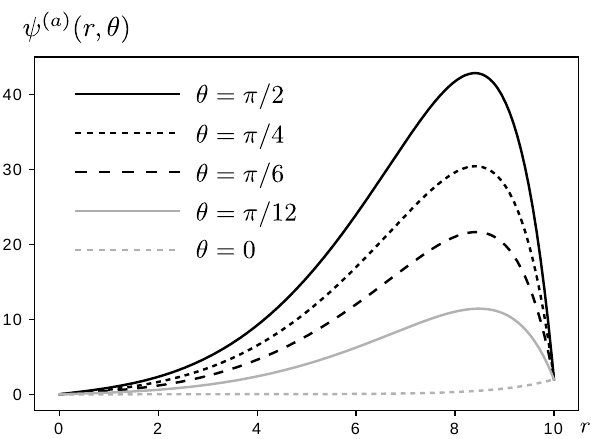
Figure 4. Solution to ψ ( a ) ( r , θ ) for different values of θ in units in which m = 1. We used N = 256.